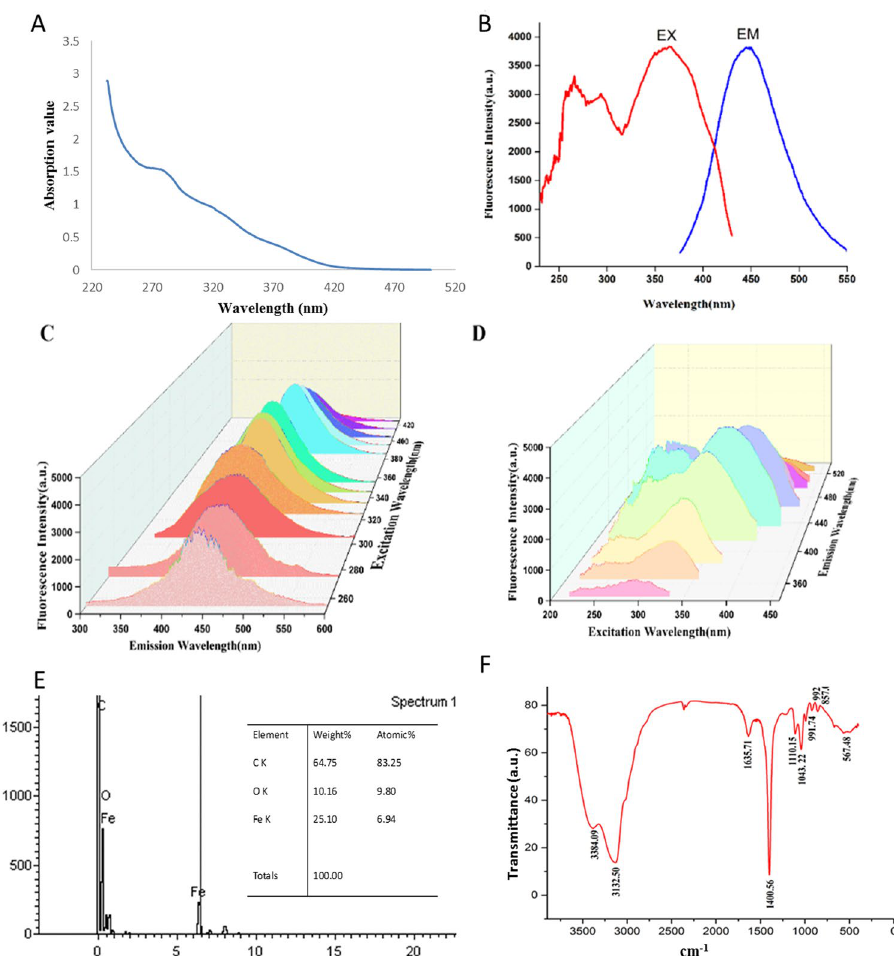
Figure 3. Characterization of egg yolk oil carbon quantum dots (EYO CDs). ( A ) UV absorption spectra of the EYO CDs at a concentration of 25 μ g/mL. ( B ) Emission spectra of EYO CDs excited at 360 nm. ( C ) Fluorescence spectra of EYO CDs with different excitation wavelengths. ( D ) Excitation spectra of EYO CDs with different emission wavelengths. ( E ) Elemental analysis of EYO CDs. ( F ) Fourier transform infrared (FTIR) spectrum of the EYO CDs (32 scans at 2 cm − 1 resolution in the scanning range of 400–4000 cm − 1